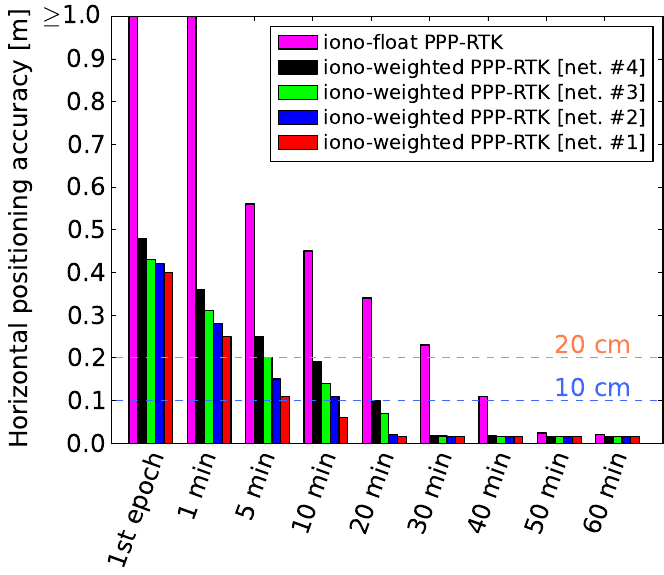
Figure 10. Horizontal positioning accuracy (90th percentile) at the first epoch and 1, 5, 10, 20, 30, 40, 50, 60 min since start for the PAR-based PPP-RTK user